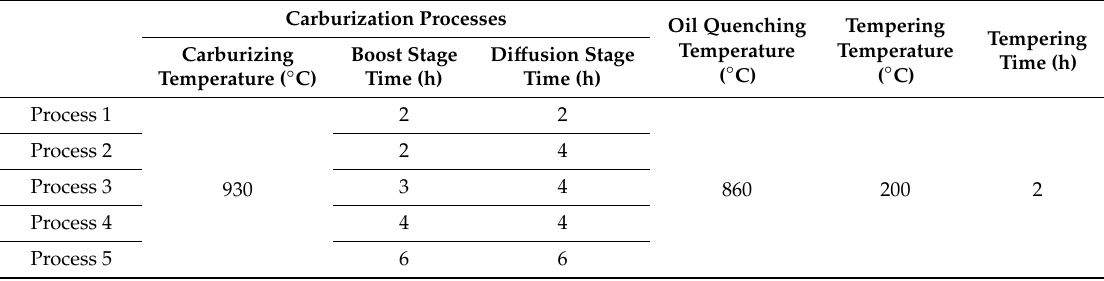
Table 1. Heat treatment